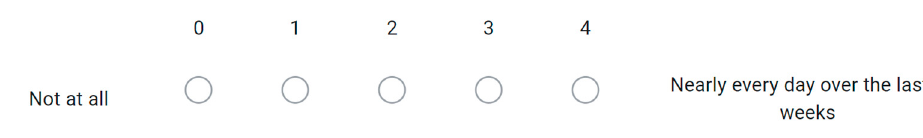
Figure 3. Likert Scale that was implemented for uncertainty and unwillingness to vaccinate against COVID-19 .